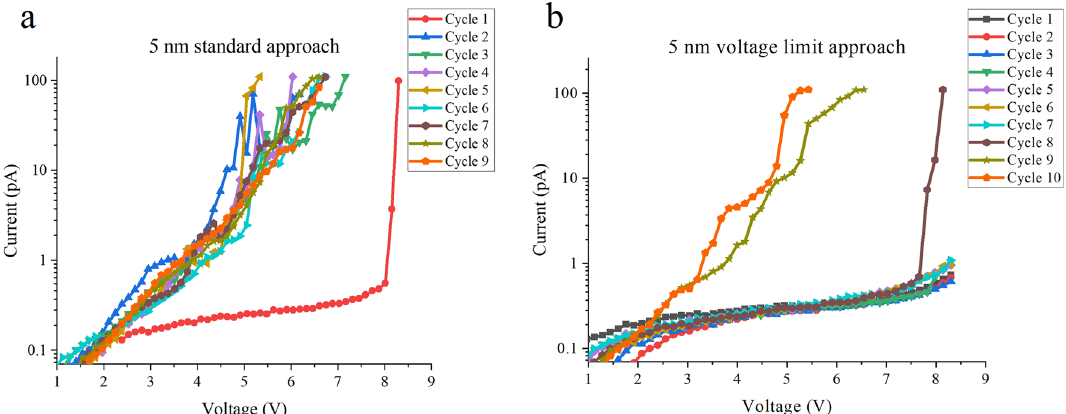
Figure 4. I-V curves for 5 nm flakes showing the two types of RVS measurement techniques. ( a ) Standard RVS with the voltage ramping until the current compliance (100 pA) is reached. ( b ) Voltage Limit RVS in which the voltage is ramped to slightly below the known BD value, in this case 8.3 V, allowing successive I-V to be undertaken before a breakdown occurs. A diamond cantilever is used for both data